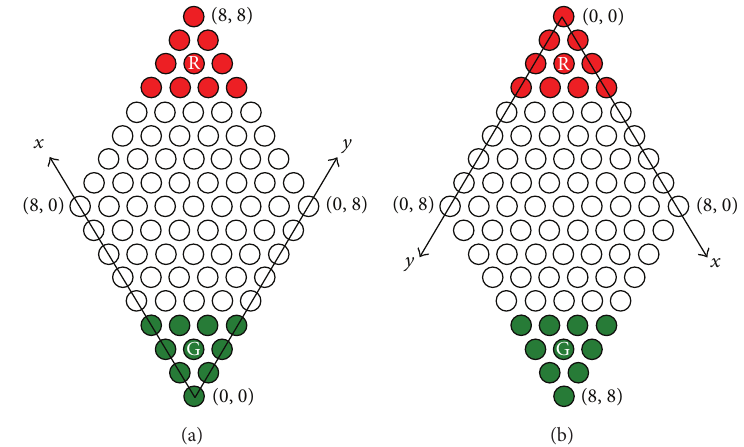
Figure 10: Unfixed coordinate system. The frames of axes in (a) and (b) are used by green and red player, respectively.